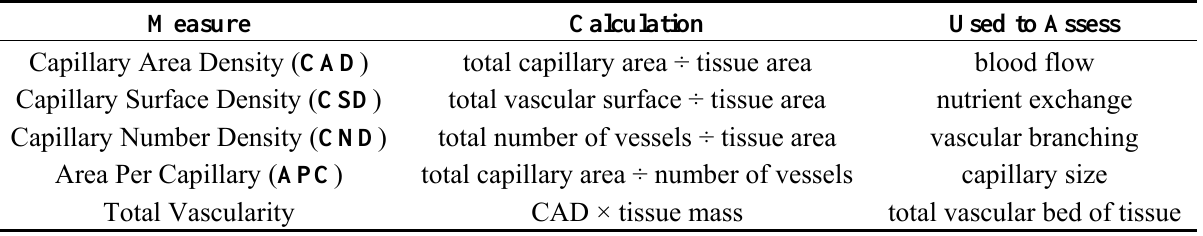
Table 2. Histological measurements to assess vascularity of nutrient transferring